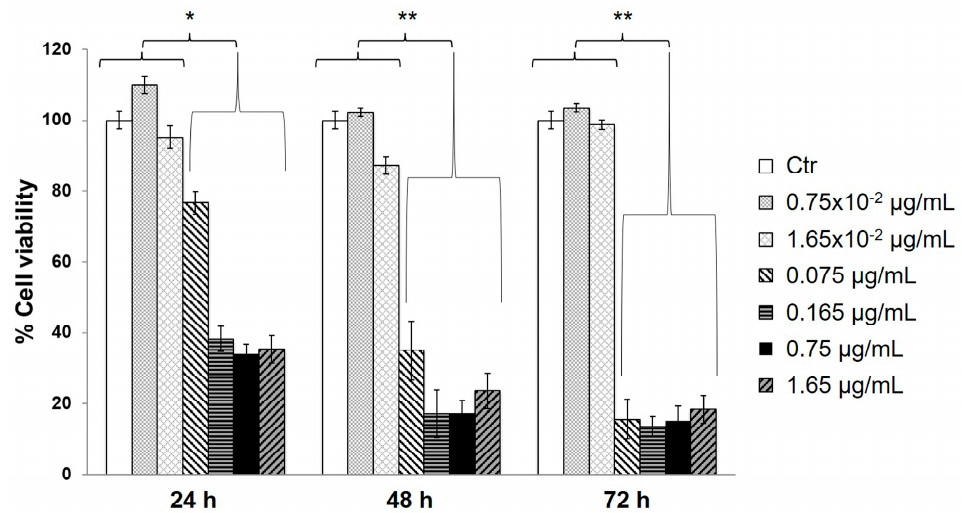
Figure 3. Analysis of viability of MG63 cells in the presence of serial dilutions of free genipin (gn). MTT assays were performed on MG63 cells cultured in the presence of gn solutions at different time points (24, 48 and 72 h). Data are reported as mean values from n = 6 biological replicates and are expressed as % viability ( ± S.E.M.) with respect to the untreated control cells (Ctr) at each time point. Statistical analysis: Student’s t -test (* p < 0.05; ** p < 0.01).